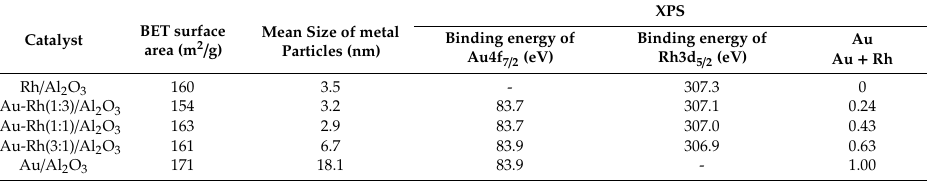
Table 1. BET, STEM and X-ray photoelectron spectroscopy (XPS) analyses of Au / Al 2 O 3 , Rh / Al 2 O 3 , and AuRh / Al 2 O 3 catalysts with specified molar ratios of